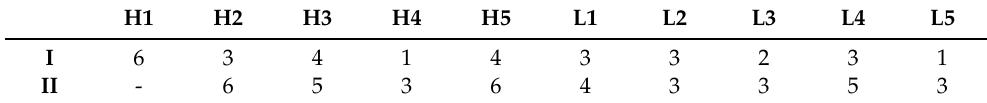
Table 1. Game scores for all volunteers in the first and the second game sessions.